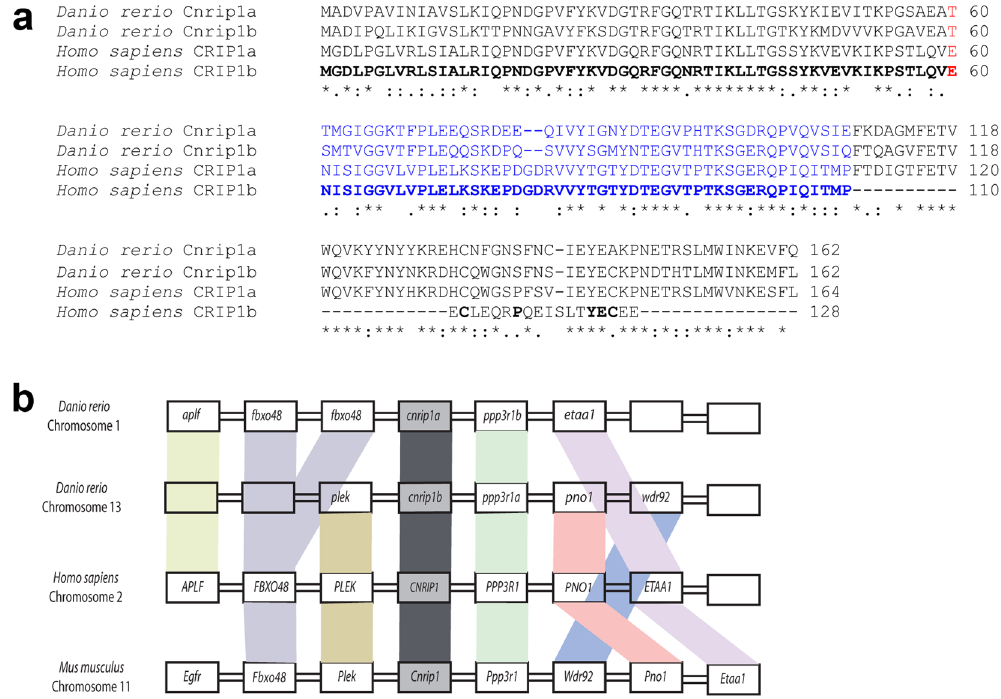
Figure 1. Cnrip1 genes in zebrafish. ( a ) Amino acid sequence alignment of Cnrip1a and Cnrip1b with the two splice variants of the single human CNRIP1 gene, named CRIP1a and CRIP1b. Distinct exons are shown in alternating black and blue font (red indicates amino acids coded by two exons). Comparing both zebrafish genes and CRIP1a asterisk indicates identity and colon similarity between all three, full stop similarity between any two. Bold indicates identity between CRIP1a and CRIP1b. ( b ) Synteny of adjacent genes in vertebrate CNRIP1 loci. Colours link homologous